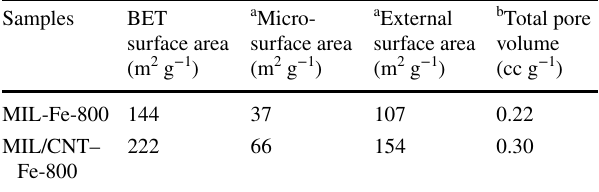
Table 1 Surface area, microporous surface areas, external surface areas, and total pore volume from the BET tests